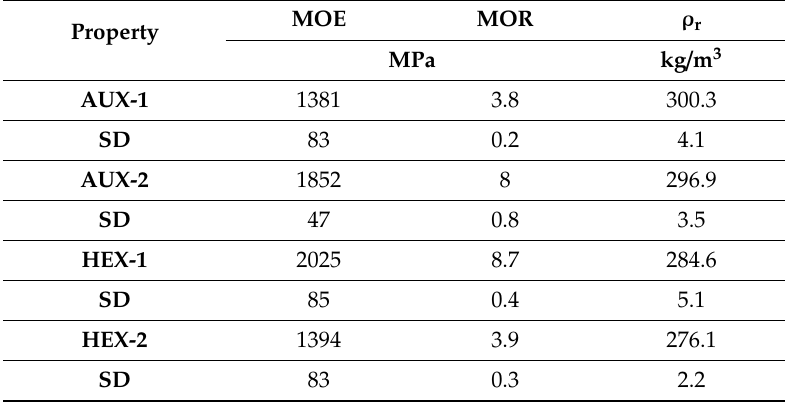
Table 3. Physical and mechanical properties of tested honeycomb panels [88].